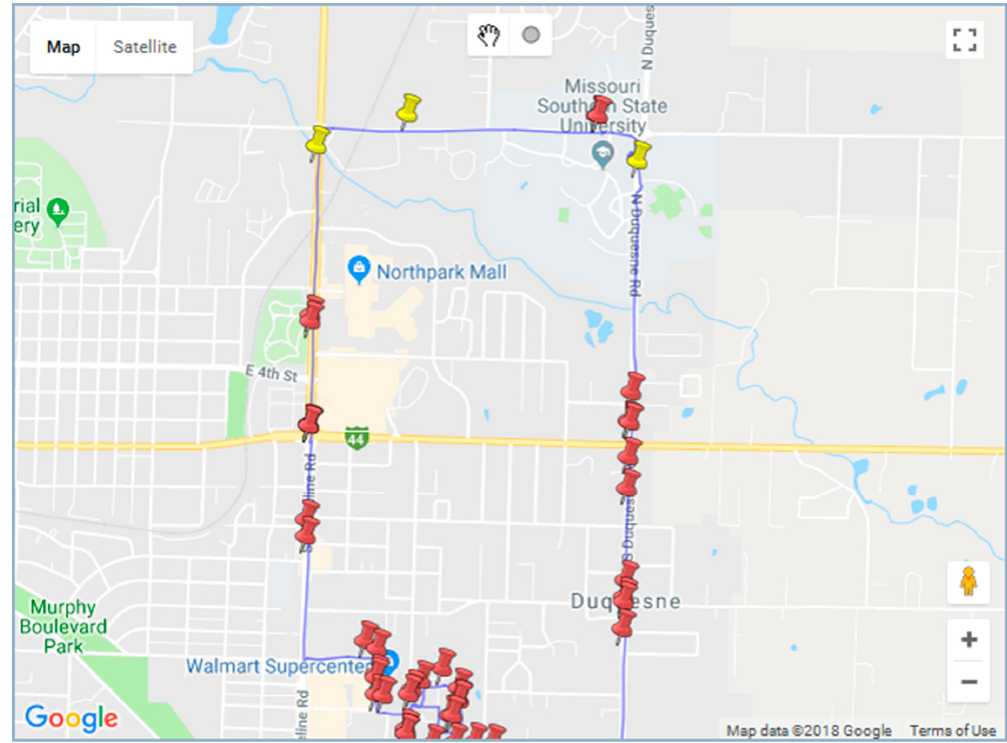
Figure 6. Visualization module showing the narratives containing the searched for keyword ‘recover*’ in yellow pins. All other narrative sentences are shown by red pins.